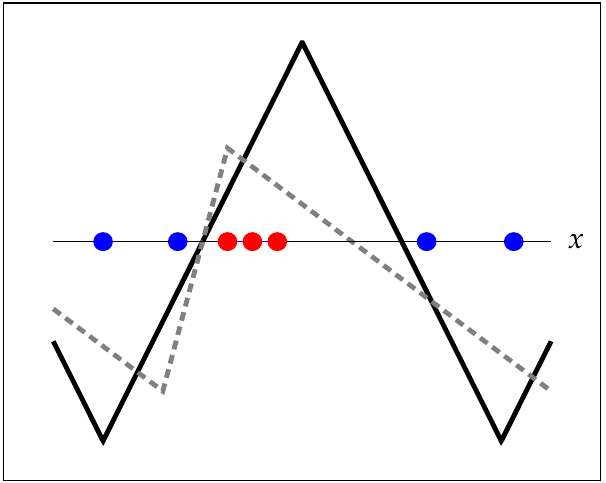
Figure 5. Asymmetric model g asy ( x , ζ ) , for ζ 0.25, 0.5, 0.75 . This model ∈ { } allows the maximization of the sum of the margins.